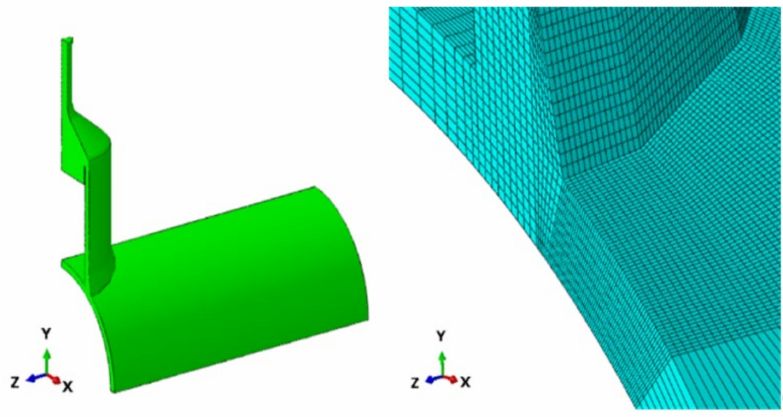
Figure 13. Model and mesh